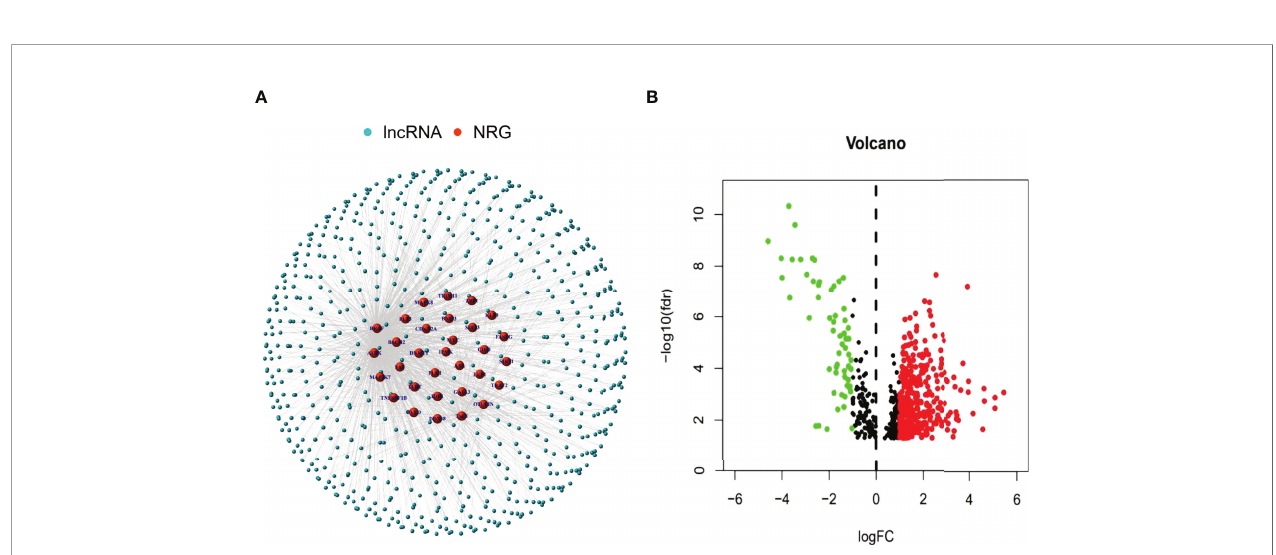
FIGURE 1 | Research